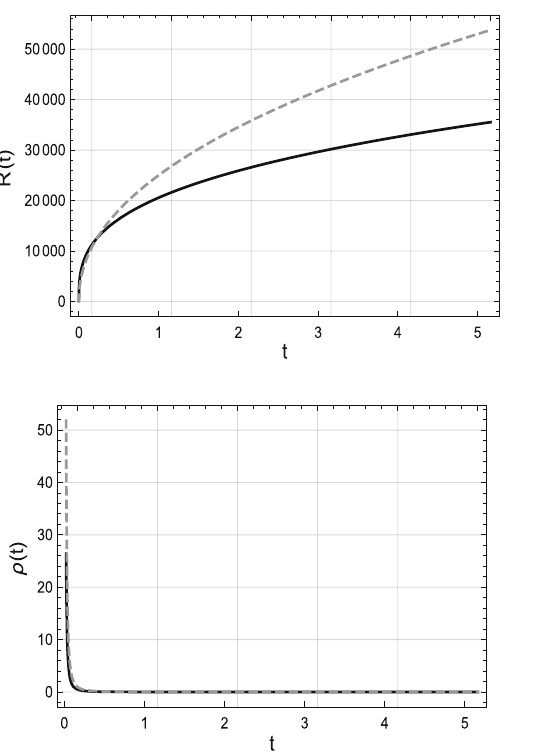
of the viscous isotropic model. We see how the effect of viscosity is suppressed with time and the solutions gradually approaches the ideal Friedmann Universe ( dashed lines